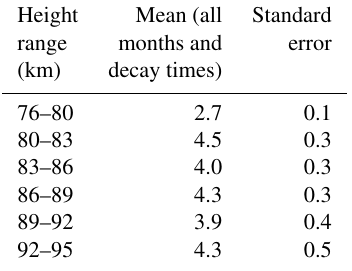
Table 2. Mean “chemical” decay times for different height regimes for Socorro, determined by using day–night differences from So- corro. Errors represent 1 standard error. See text for